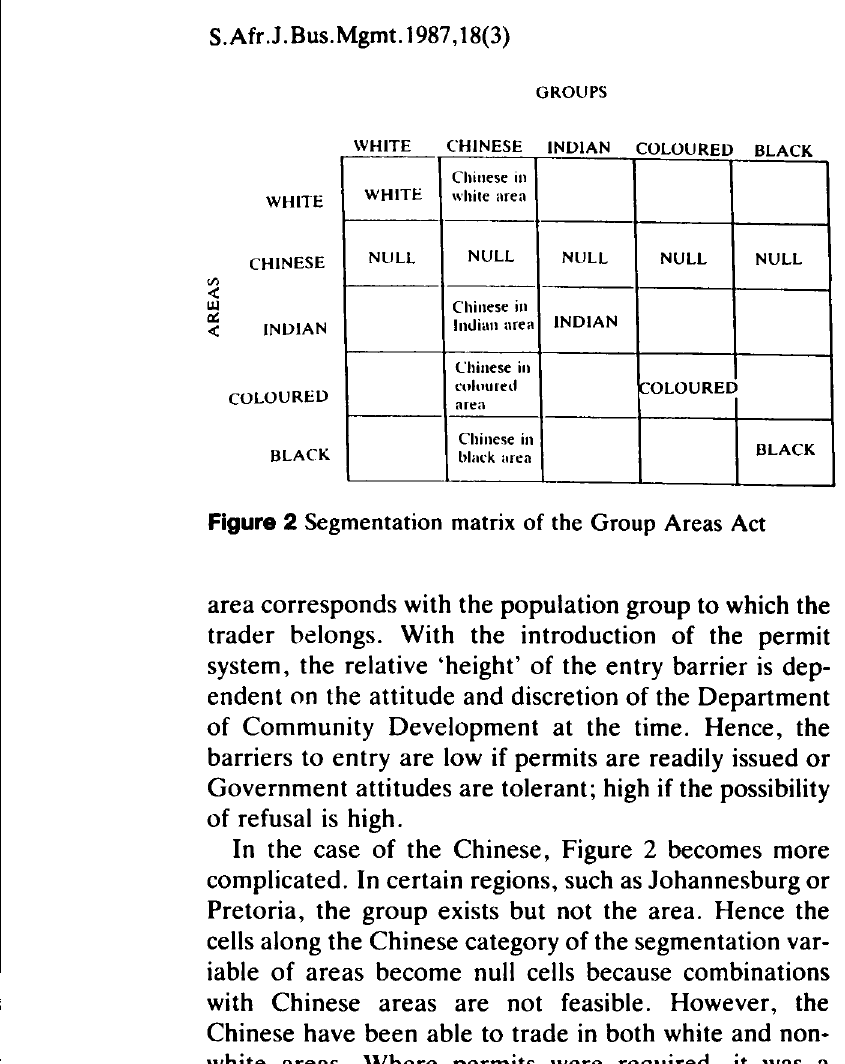
area corresponds with the population group to which the trader belongs. With the introduction of the permit system, the relative 'height' of the entry barrier is dep endent on the attitude and discretion of the Department of Community Development at the time. Hence, the barriers to entry are low if permits are readily issued or Government attitudes are tolerant; high if the possibility of refusal is